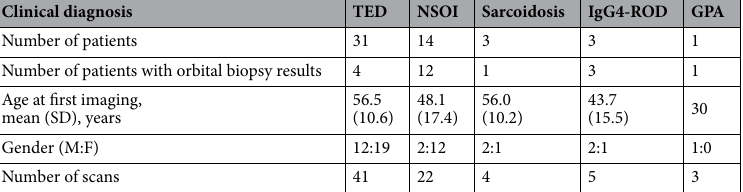
Table 1. Demographics of patients and number of imaging studies. TED thyroid eye disease, NSOI non- specific orbital inflammation, IgG4-ROD IgG4-related ophthalmic disease, GPA Granulomatosis with polyangiitis.